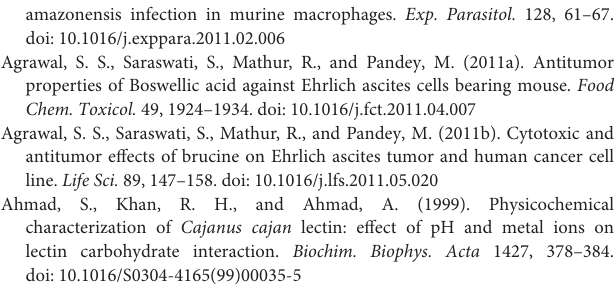
Figure S1 | Structural model (A) Predicted amino acids sequence from Eutirucallin, evidencing secondary structure. (B) Heterogeneous binding potential in amino acids structure of Eutirucallin such as NAG, N-acetilglucosamine; GAL, Galactose; BMA, e beta-D-mannopyranose. (C) Predicted binding site of GAL in the Eutirucallin structure. (D) Predicted structural model from